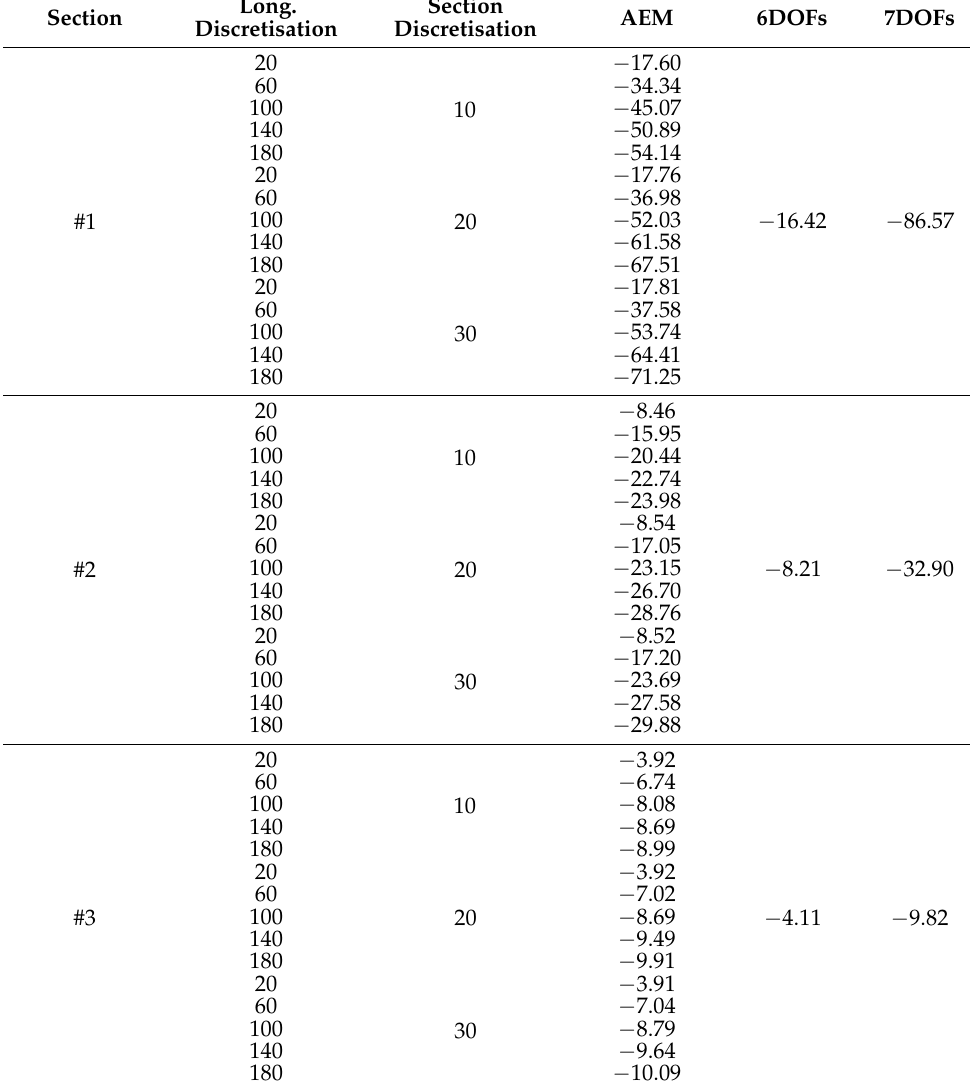
Figure 6. Vertical displacement–length relation for Section #3 with the different discretisation configurations. For the sake of brevity, the displacement values for all the discretisation configura- tions and sections are reported in Table 2, only for the longer length (i.e., L = 1000 mm). Table 2. Centroid vertical displacement (mm) for the three considered sections with different con- figurations and discretisation levels (L = 1000 mm).